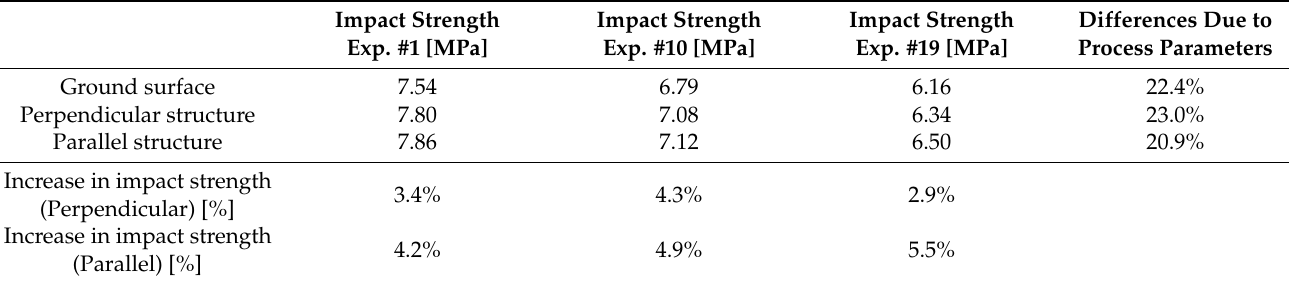
Table 10. The values of the impact bending stress in three experiments and the percentage of increase in structured specimens.